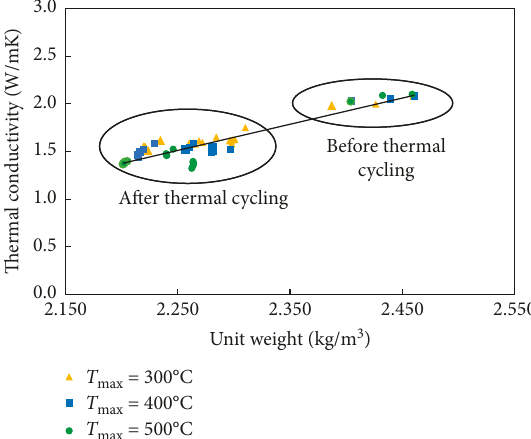
Figure 13: Relationship between the thermal conductivity and unit weight of the UHPC at different maximum temperatures.